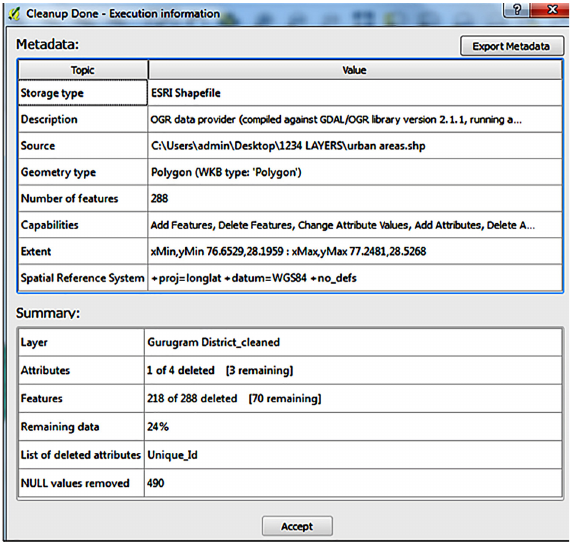
Fig. 12. Quality information of geospatial data.